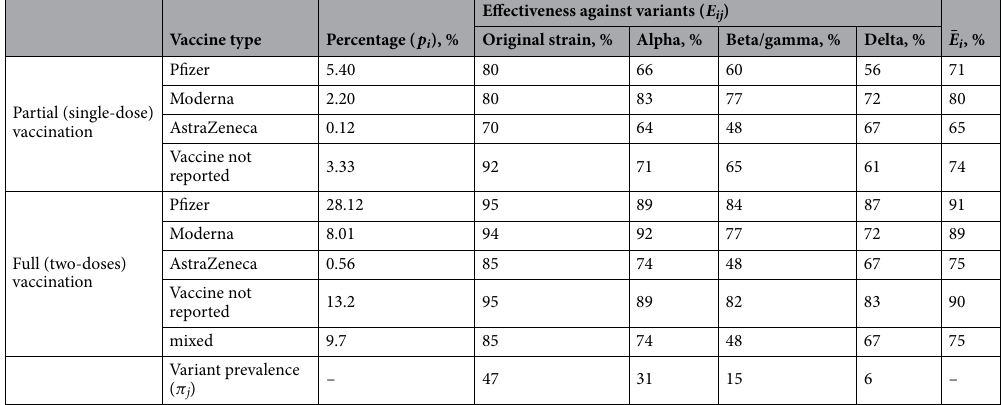
Table 2. Cumulative percentage of people who have received a COVID-19 vaccine in Canada by vaccine product and effectiveness in partially and fully vaccinated cases as of July 31,